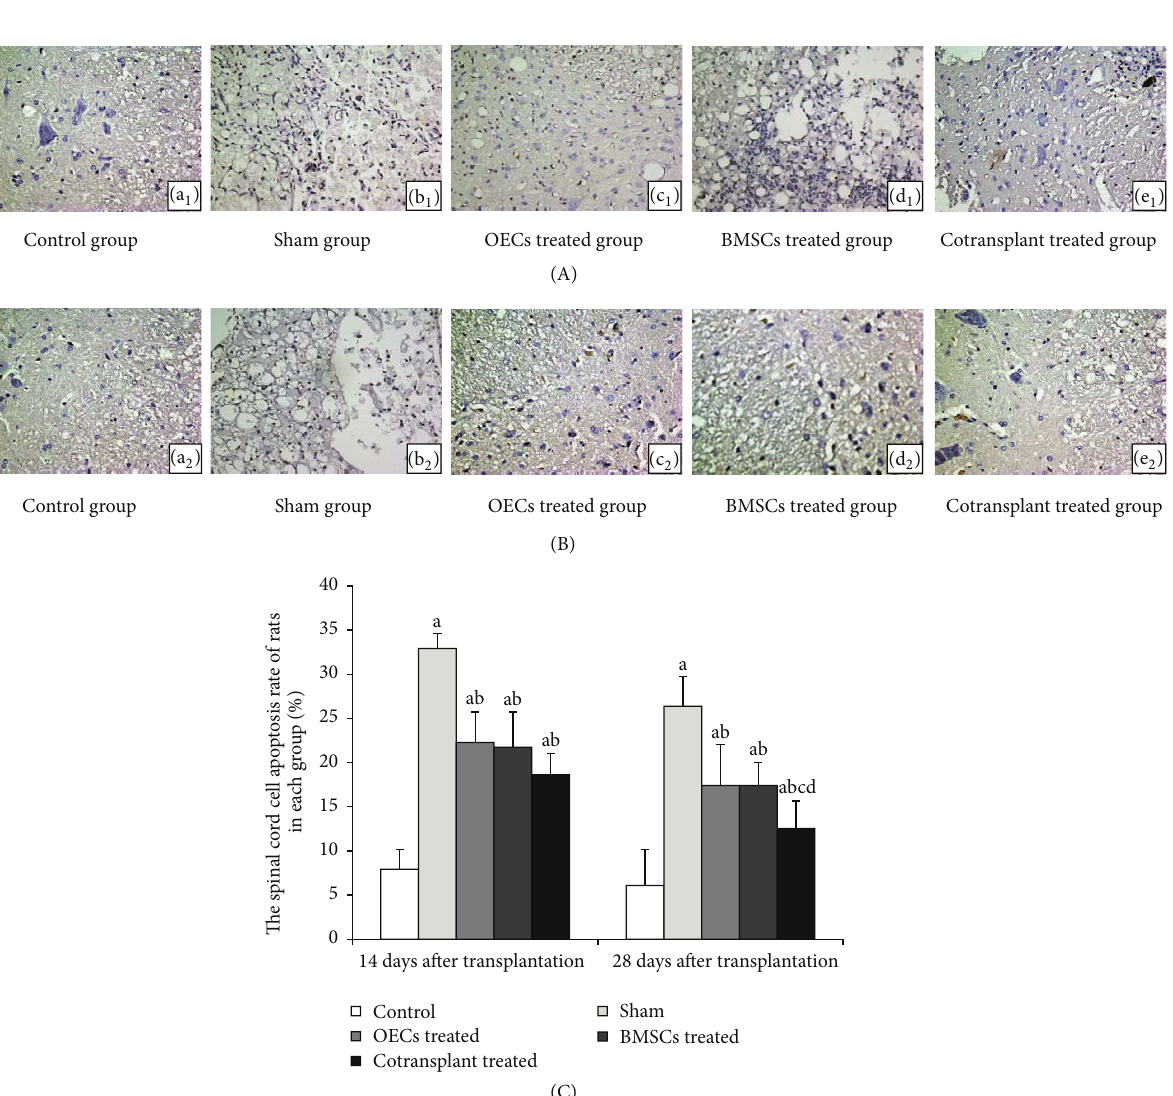
Figure 5: Cellular apoptosis after spinal cord injury was reduced by OECs and BMSCs (TUNEL staining, 10 × 40). Note: (A) 14 days after transplantation; (B) 28 days after transplantation; (a 1 , a 2 ) control group; (b 1 , b 2 ) sham group; (c 1 , c 2 ) OECs treated group; (d 1 , d 2 ) BMSCs treated group; (e 1 , e 2 ) cotransplant treated group. (C) The spinal cord cell apoptosis rate of rats in each group. a 𝑃 < 0.05 versus control group; b 𝑃 < 0.05 versus sham group; c 𝑃 < 0.05 versus OECs treated group; and d 𝑃 < 0.05 versus BMSCs treated group.